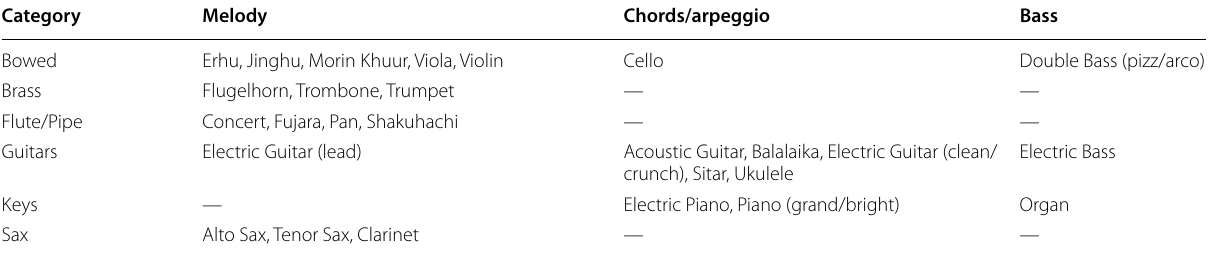
Table 2 List of samplers used to produce the dataset ordered by instrument categories and band functions Category